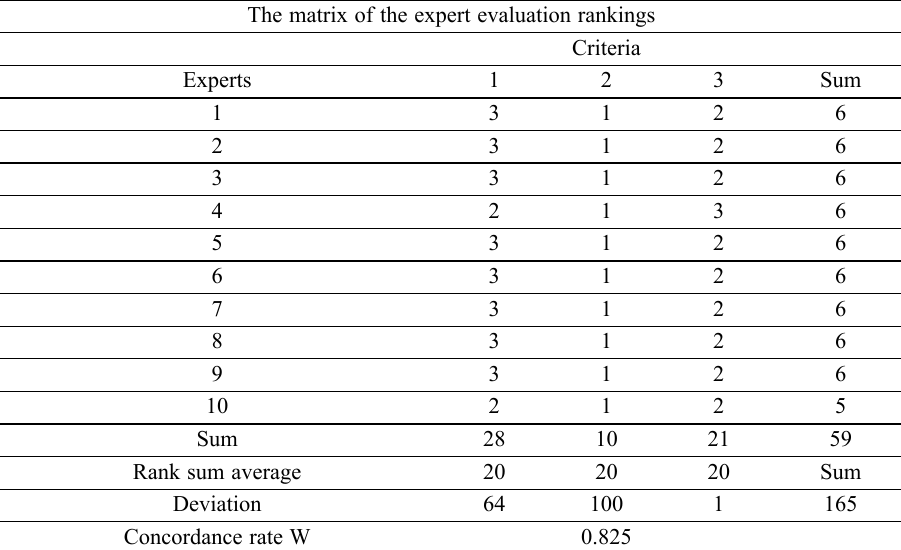
Table A.2. The matrix of the expert evaluation